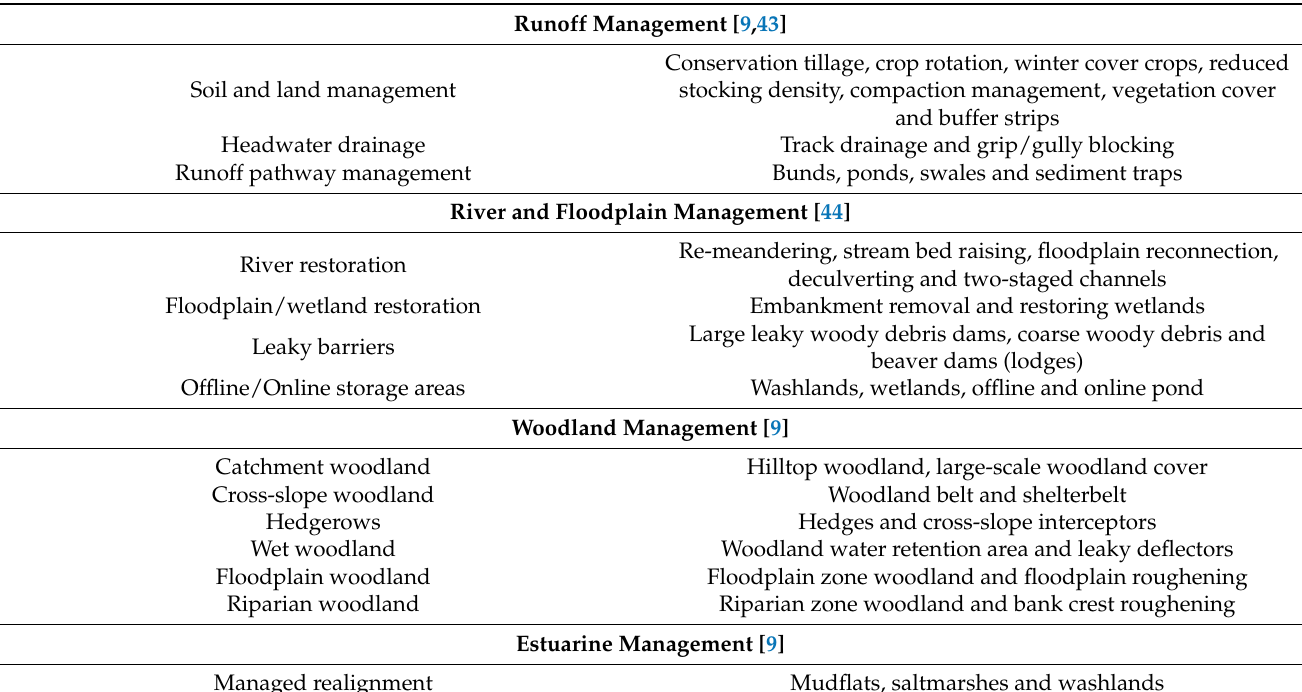
Table 2. Source to sea NFM